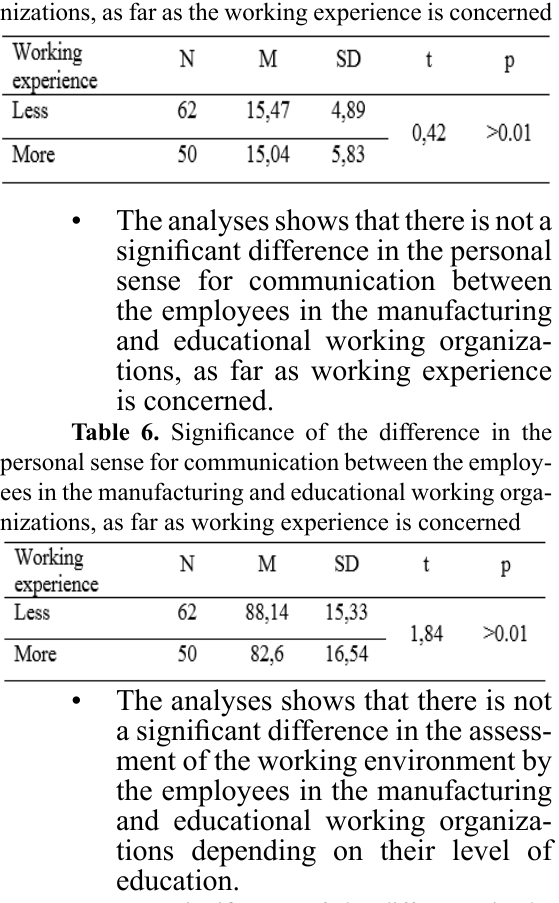
Table 7. Significance of the difference in the assessment of the working environment by the employ - ees in the manufacturing and educational working orga - nizations, depending on their level of education